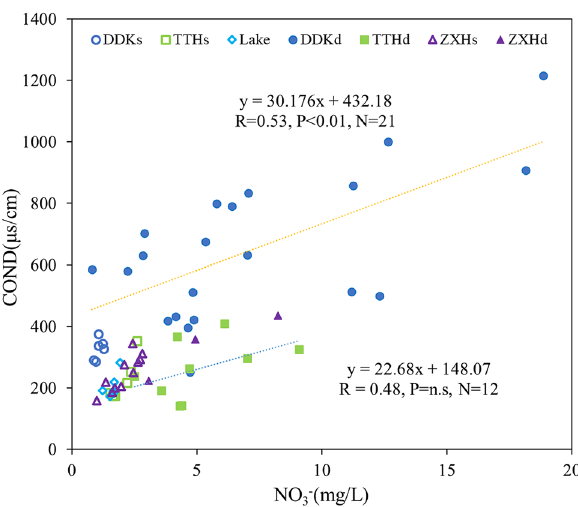
Figure 4. The relationships between COND vs. NO 3− in surface-ground water (R is Pearson correlation; P indicates that the correlation is significant at the 0.01 level (2 tails); N represents the number of statistical samples; n.s. = nonsignificant and p >